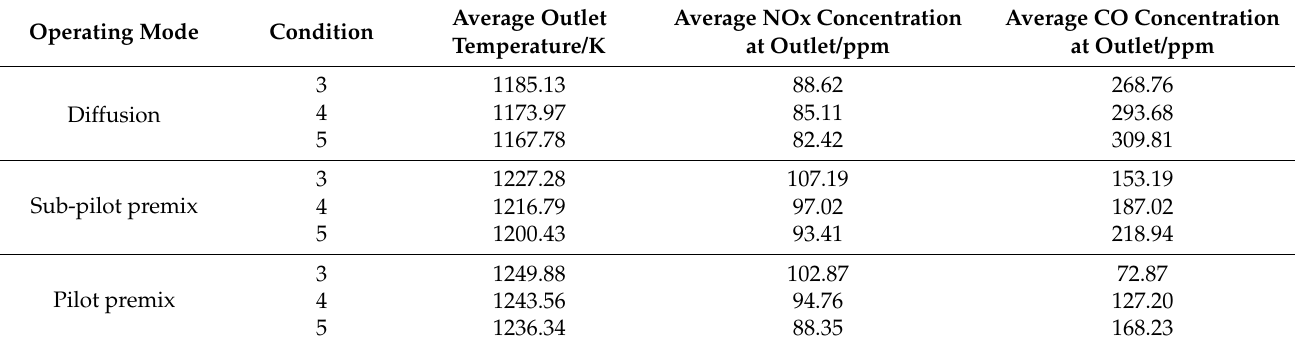
Table 11. Simulation results of temperature